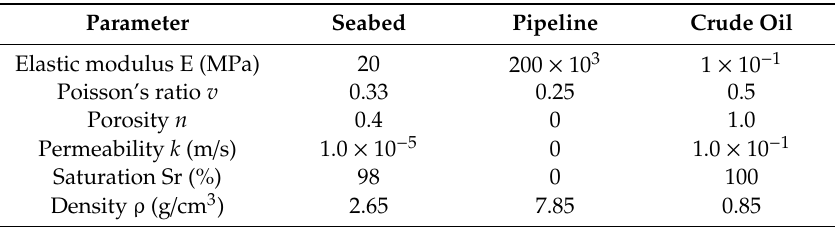
Table 1. Model parameters of seabed foundation, pipeline and crude